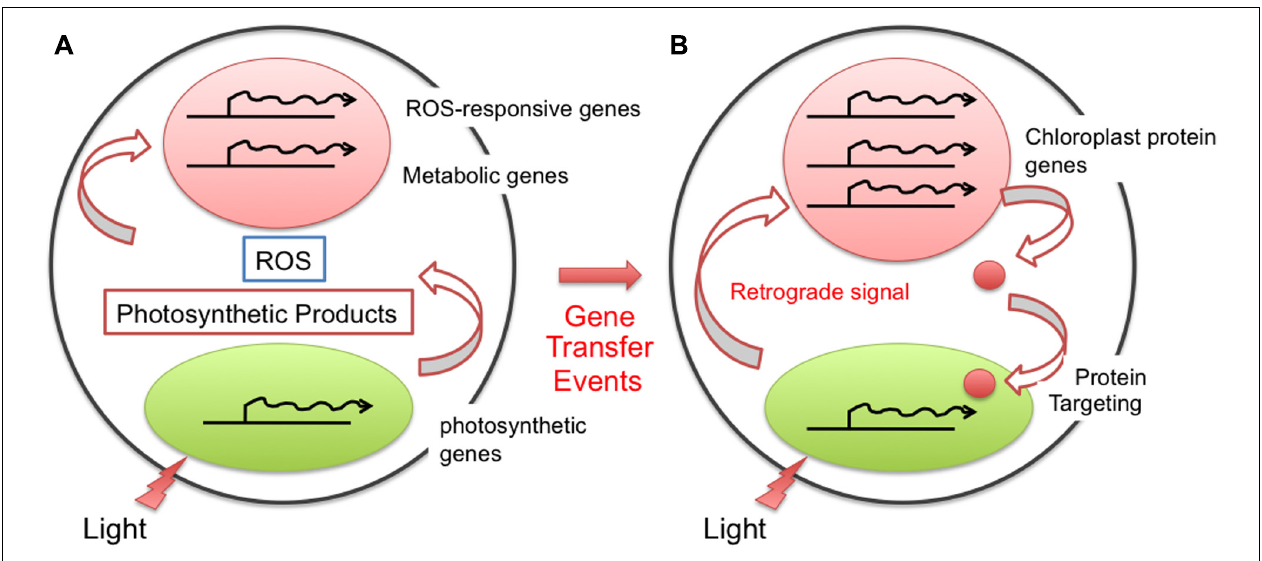
event, and thus the nucleus was likely able to cope with them without any specific evolution (A) . After the gene transfer event from the chloroplast to the nucleus, the location of the gene and its function differentiated.To modulate the function and amount of the gene product properly, the cell evolved a regulatory loop through a specific retrograde signaling pathway (B)